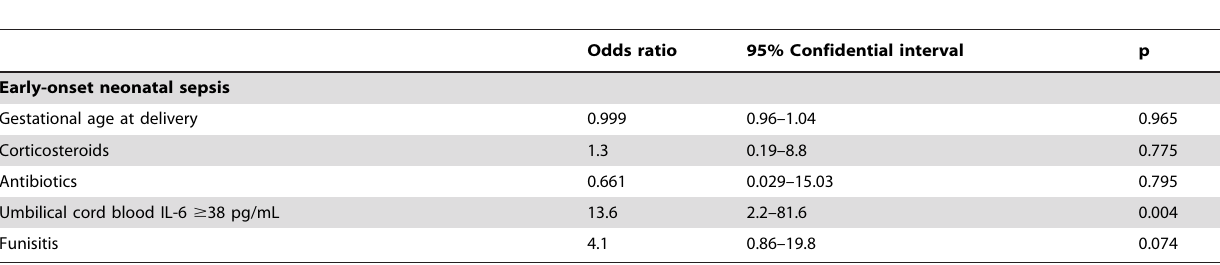
Table 3. Relationship between umbilical cord blood IL-6 and funisitis and early-onset neonatal sepsis analyzed by binary logistic